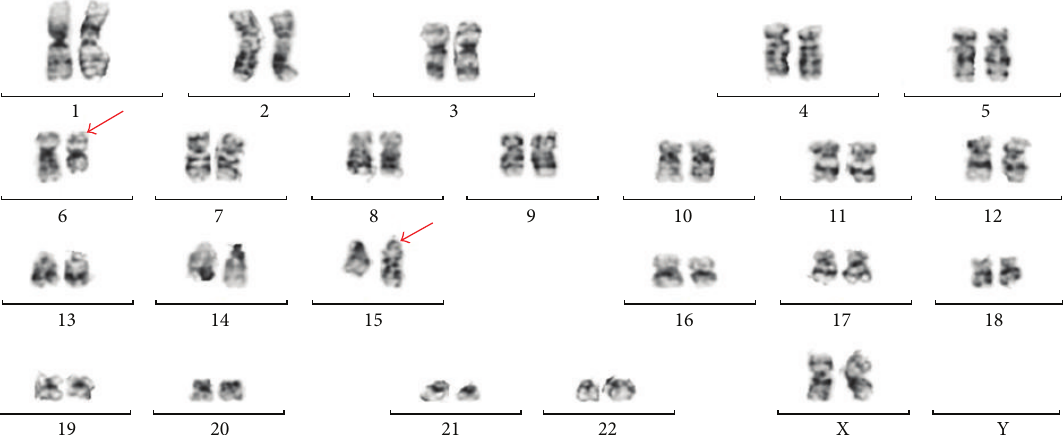
Figure 3: Cytogenetic karyotype. Karyotype of bone marrow aspirate cells showing t(6;15)(q12;q15). Red arrows show involved chromosomes 6 and